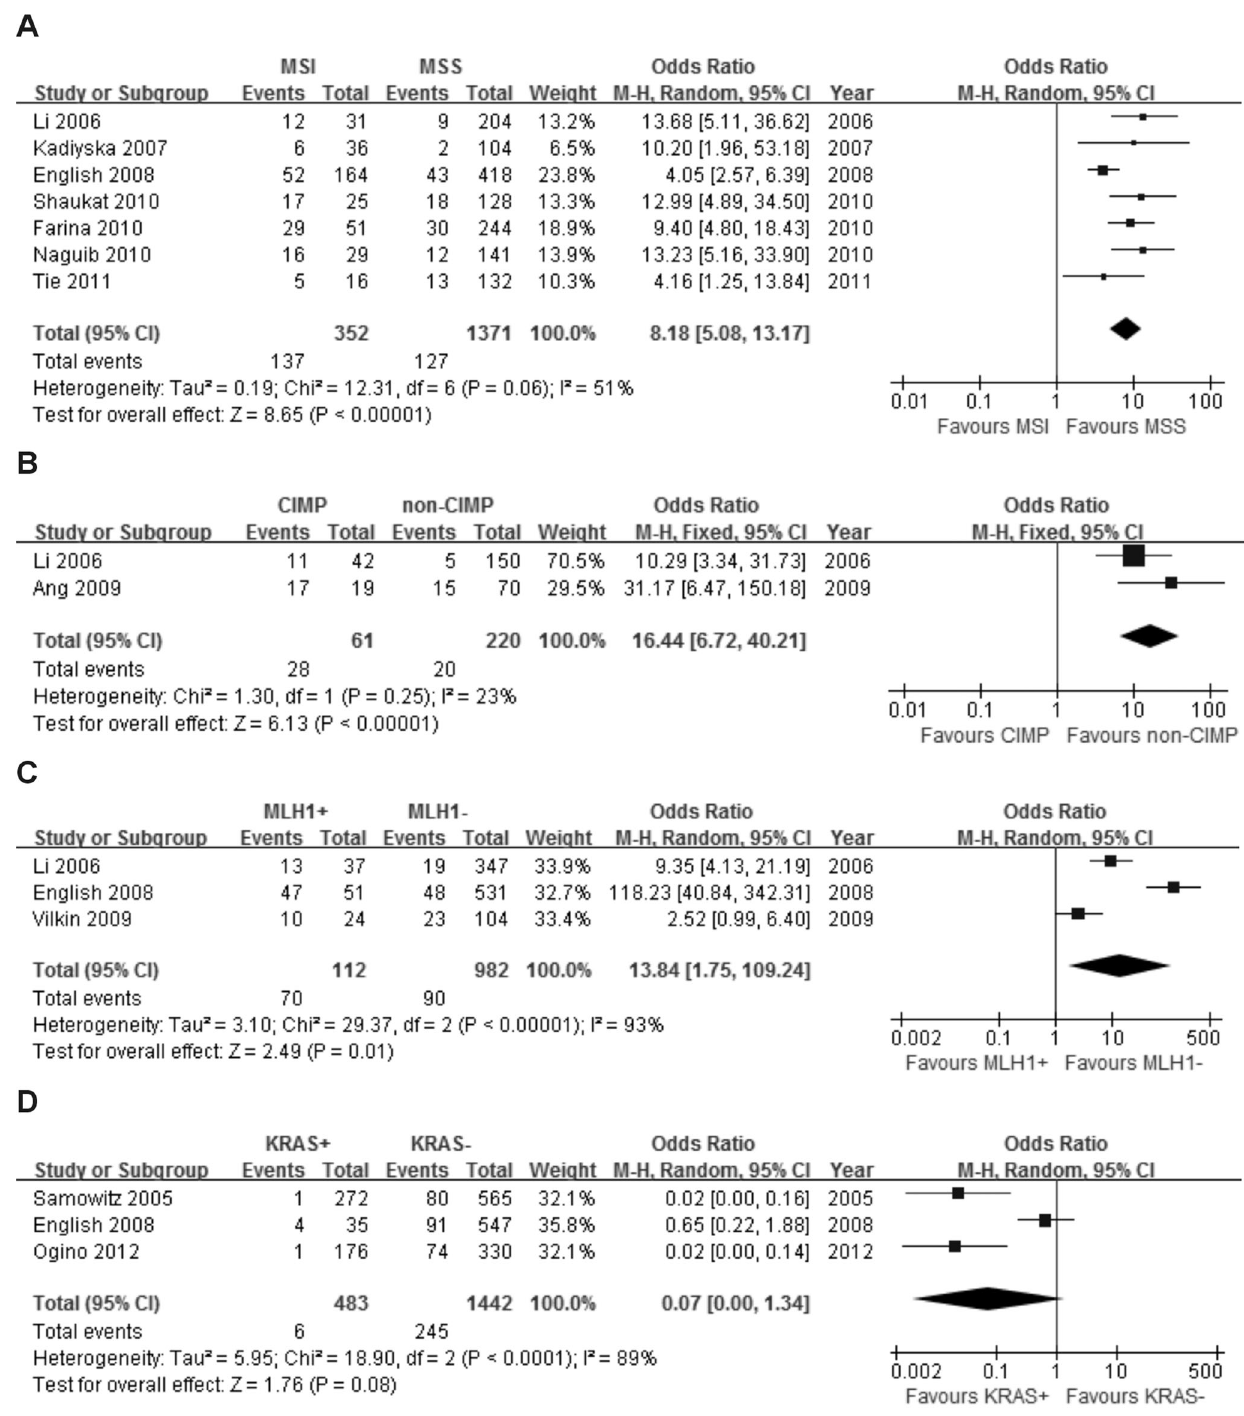
Figure 5. The association of BRAF V600E mutation with molecular features. Random effects model of the odds ratios (ORs) with 95% confidence intervals (CIs) of the association of BRAF V600E mutation with MSI status (A), MLH1 status (C) and KRAS mutation (D). Fixed effects model of the odds ratios (ORs) with 95% confidence intervals (CIs) of the association of BRAF V600E mutation with CIMP status (B).